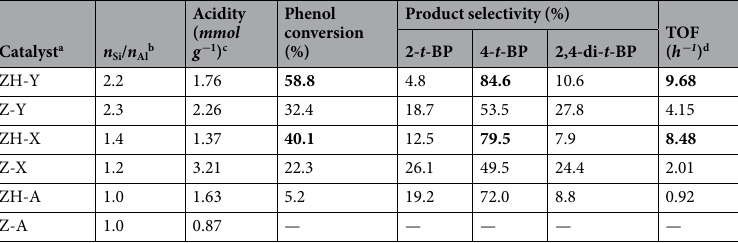
Catalyst a n Si / n Alb